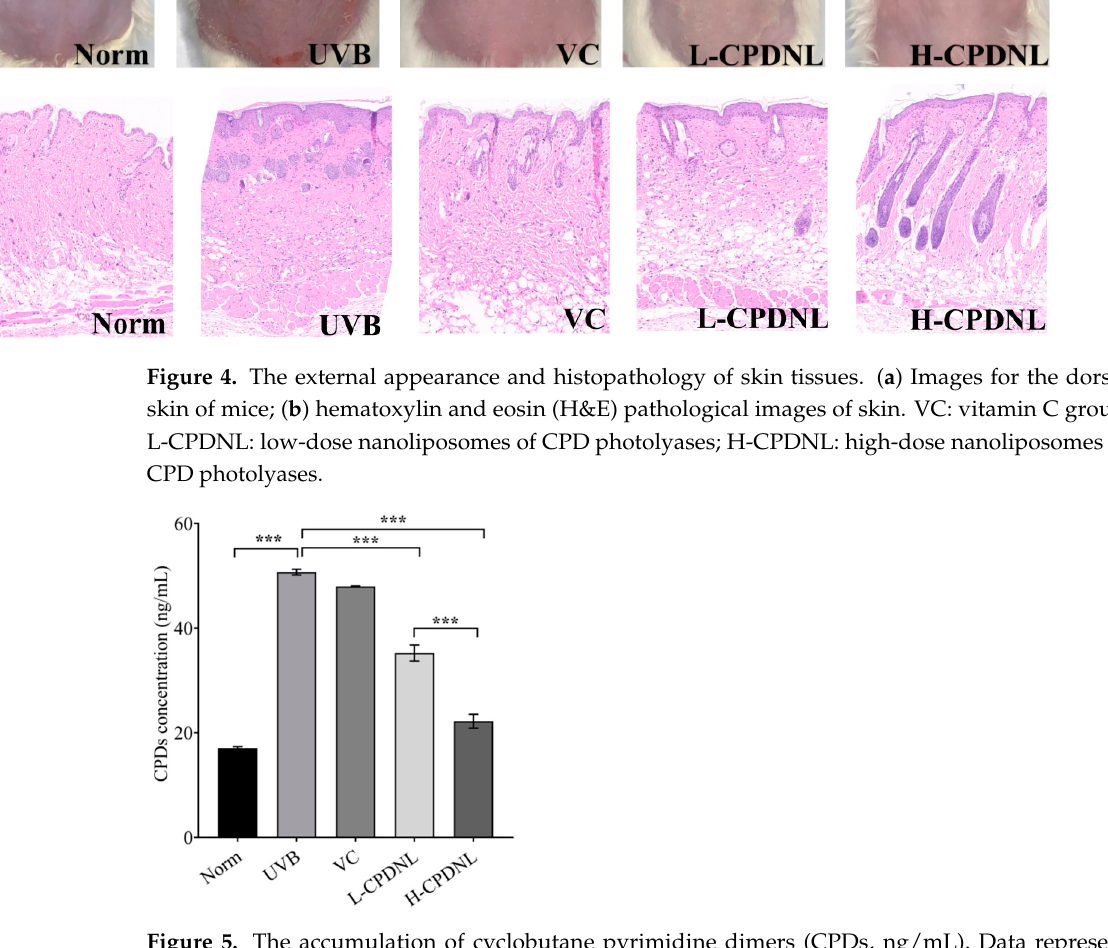
Figure 4. The external appearance and histopathology of skin tissues. ( a ) Images for the dorsal skin of mice; ( b ) hematoxylin and eosin (H&E) pathological images of skin. VC: vitamin C group; L-CPDNL: low-dose nanoliposomes of CPD photolyases; H-CPDNL: high-dose nanoliposomes of CPD photolyases.